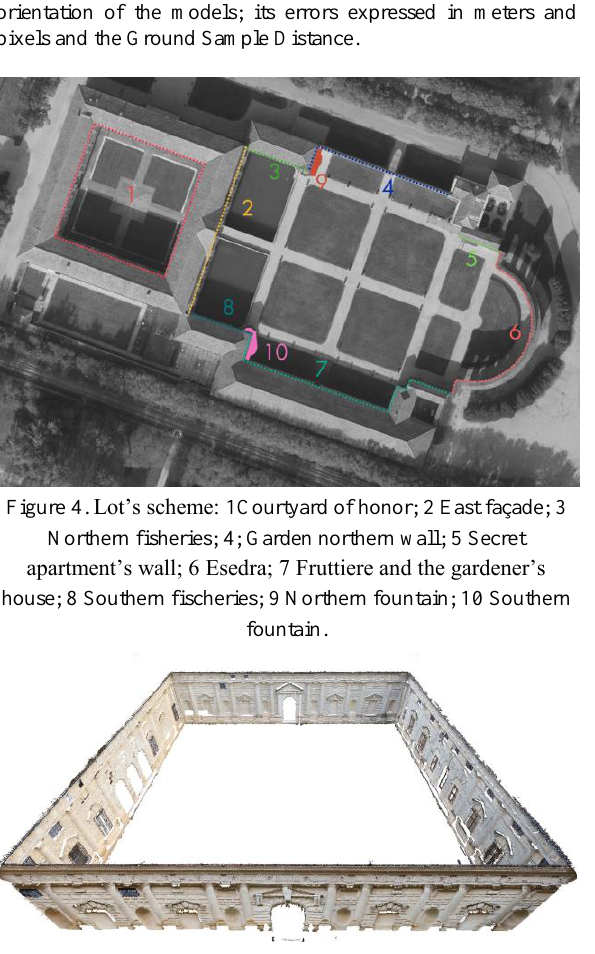
Figure 5. Lot: Courtyard of Honour. Photogrammetric dense